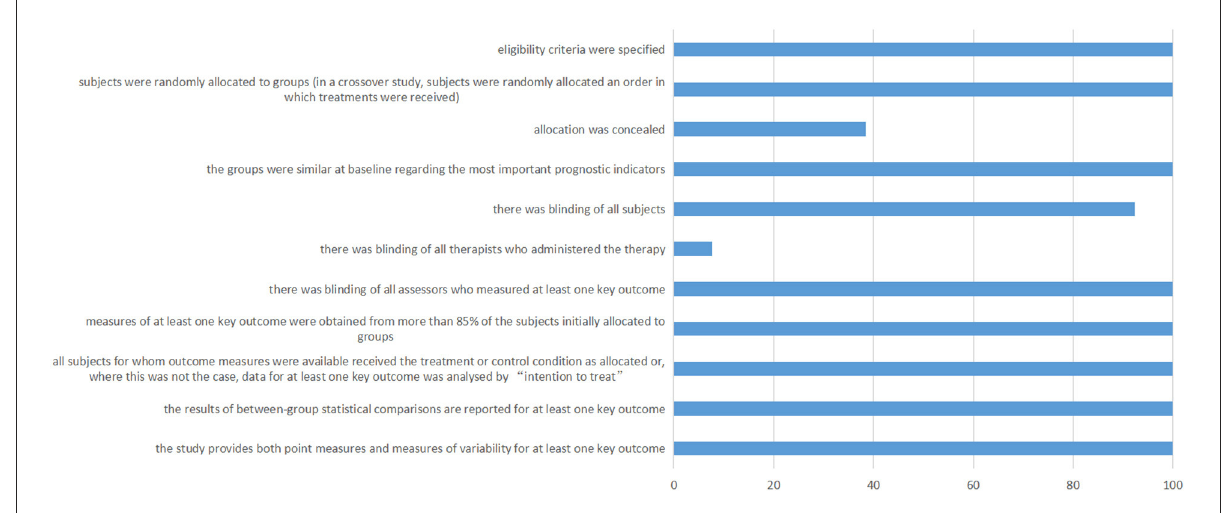
FIGURE6 PEDro scale of included studies. The horizontal axis represents the percentage of